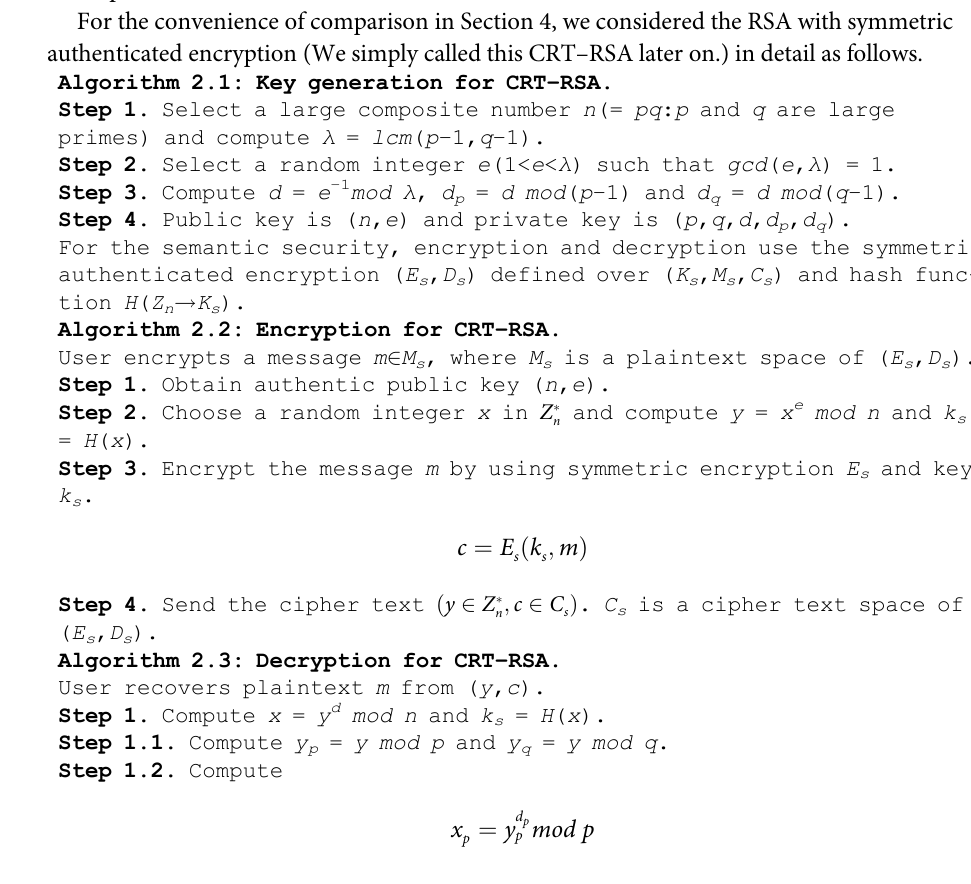
Algorithm 2.1: Key generation for CRT–RSA .